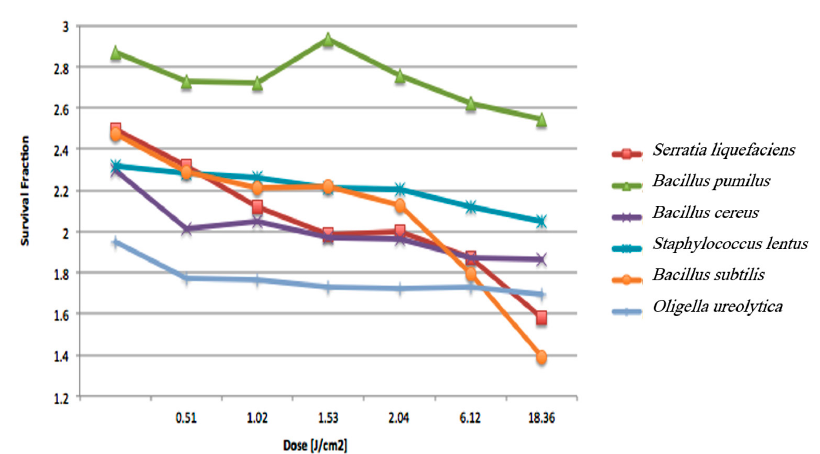
Fig. 2. Survival fraction versus UV dose for the six bacteria isolated from the in-duct of air conditioning